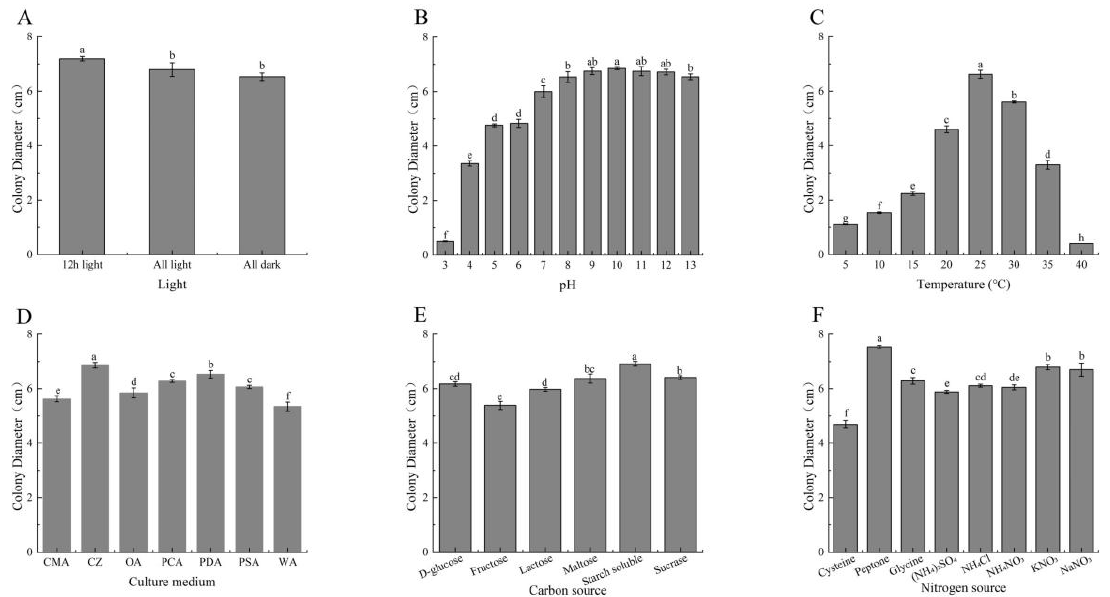
Figure 4. Biological characteristics of F. equiseti . ( A ) Light condition; ( B ) pH; ( C ) temperature; ( D ) medium; ( E ) carbon source; ( F ) nitrogen source. Different letters indicate significant differences according to ANOVA.